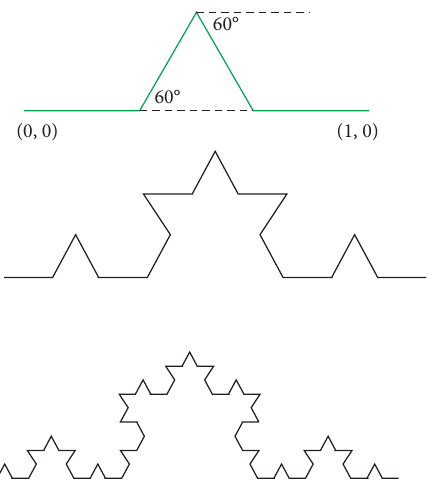
Figure 2: Koch curve construction based on the generator, orders 1 and 2 and length �